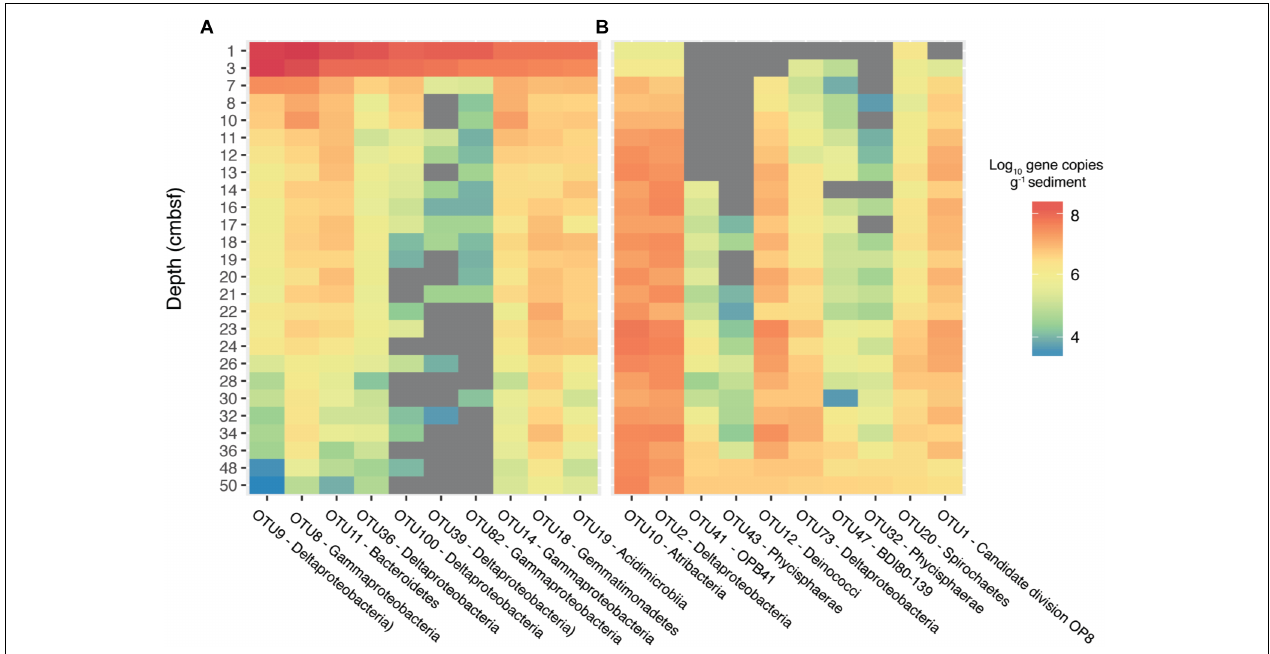
FIGURE 4 | Estimated absolute abundances of the most dominant OTUs identified by sequencing of 16S rRNA gene. Absolute abundances were calculated by multiplying relative sequence abundances by gene copy numbers obtained from qPCR of the 16S rRNA gene, assuming an average of 4.1 and 1.6 16S rRNA operons per cell for bacteria and archaea, respectively. The top ten most abundant OTUs present at 3 cmbsf are displayed in (A) and the top ten most abundant OTUs present at 50 cmbsf are displayed in (B) . The color represents the log 10 absolute abundance of each OTU. Gray areas represent depths where no sequences were recovered for the specified